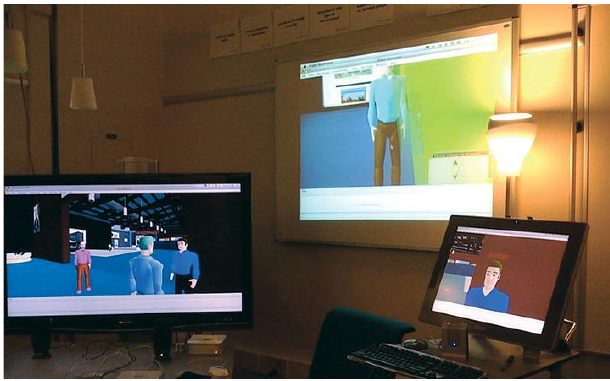
Figure 2. inSpace resources for presentations support [16].